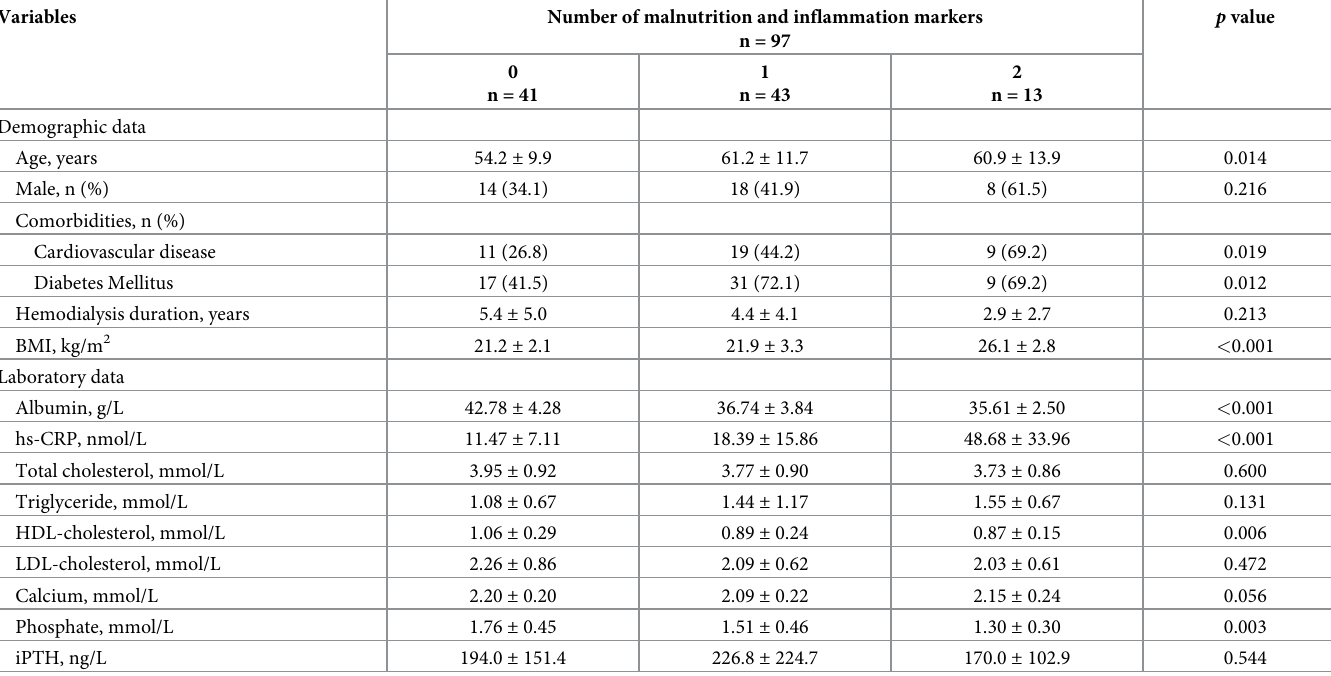
Table 2. Clinical characteristics and laboratory results according to the number of malnutrition and inflammation